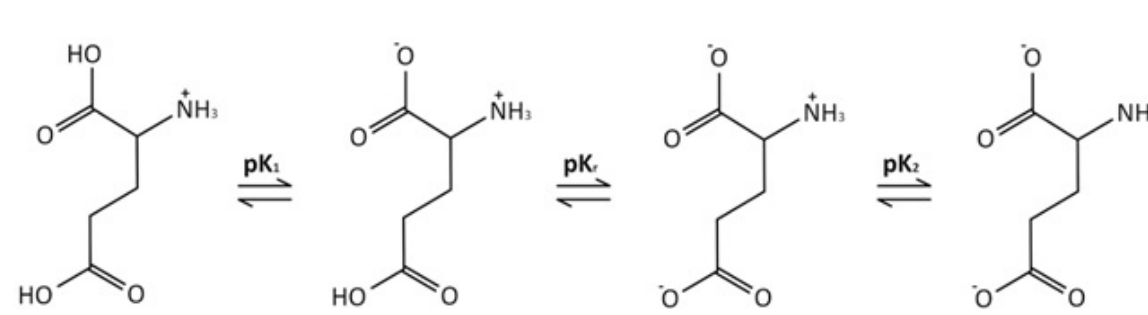
Figure 3 - L-aspartic acid equilibrium in aqueous medium.